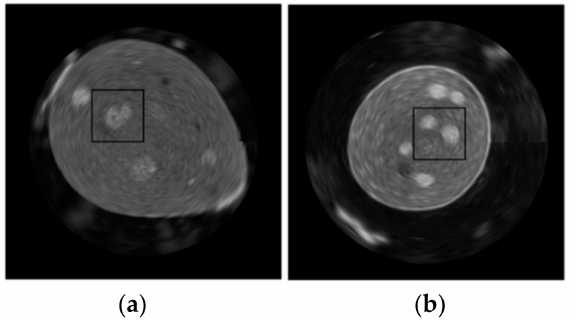
Figure 8. Chosen region of interest for both examined breast phantoms: ( a ) Blue, ( b ) ATS BB-1. The mean values outside the structure have been calculated for the appropriately masked images. This parameter helps to evaluate the amount of artifacts generated by the probe that arose as a result of reflection from the border of the structure. In addition to the number of artifacts outside the structure, this parameter can also suggest the possibility of forming unwanted artifacts inside the structure due to reflection on the tissue border parallel to the breast skin in the examination position. The mask example used, and the masked image are shown in Figure 9.